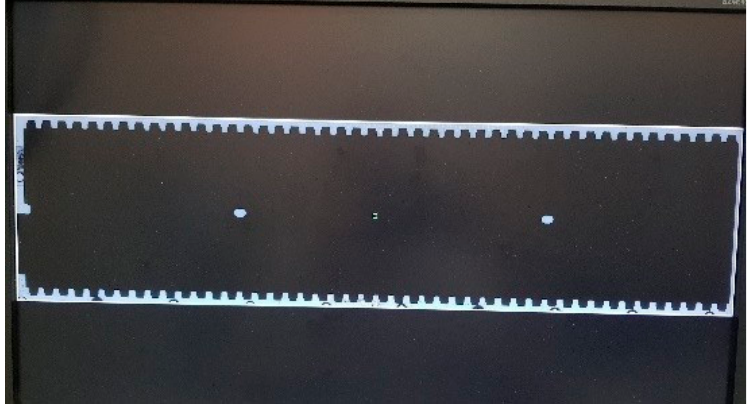
Figure 4. View of the pattern scanned with the optical sensor of the Werth Multisensory Measuring Machine (image after dynamic scanning using the scanning raster) (own study).